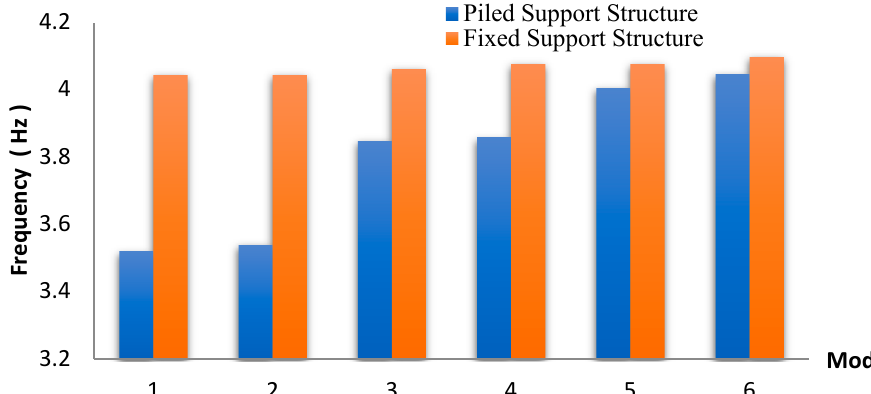
Figure 17. The comparison of natural frequencies that resulted from the piled support structure model and the fixed support structure model.